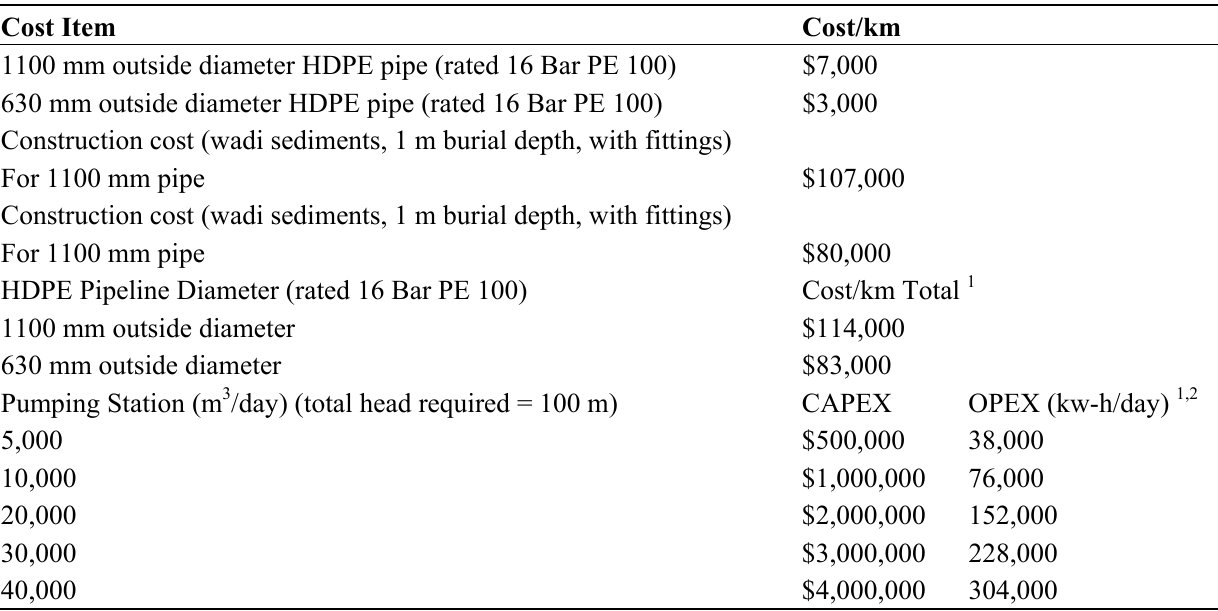
Table 2. Estimated cost for construction of high-density polyethylene pipe (HDPE) pipelines in wadi